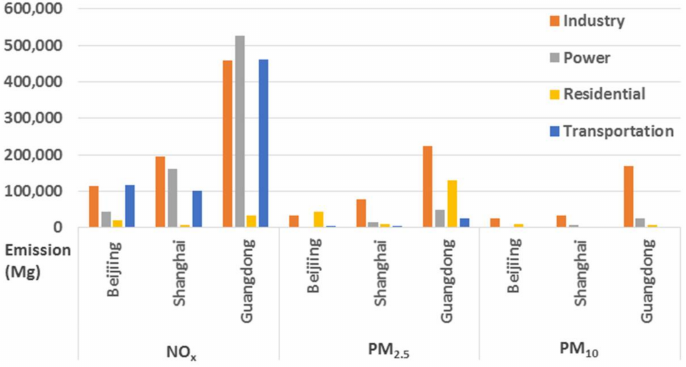
Figure 1. Emissions of industry, power, residential, and transportation in Beijing, Shanghai, and Guangdong province in 2012. Data are from the Multi-resolution Inventory for China (MEIC)